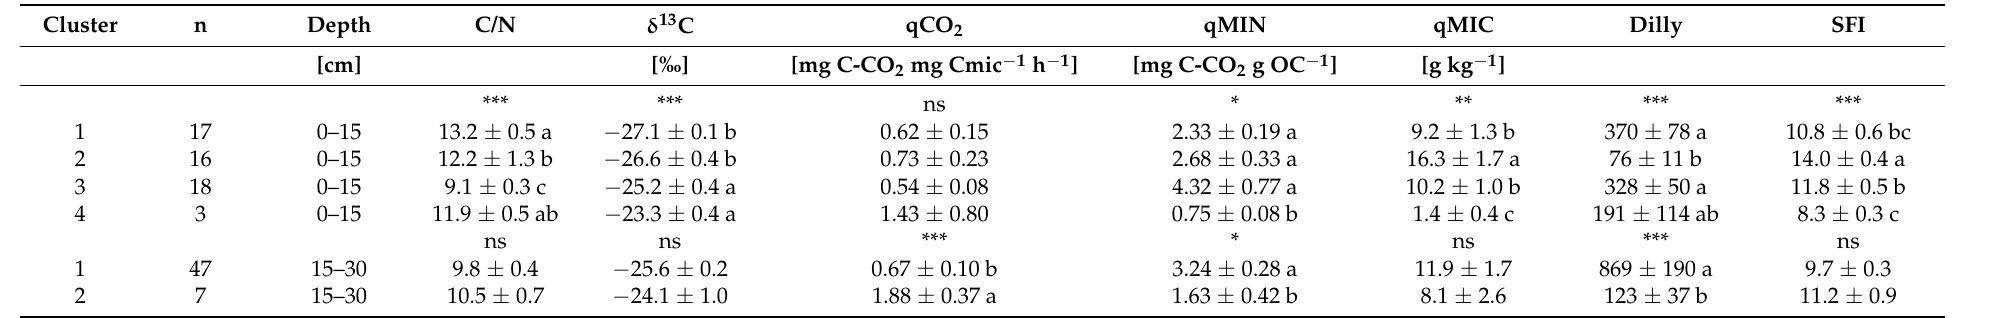
Table 2. Means ± standard errors of several indicators of each cluster at 0–15 and 15–30 cm depth, with the Kruskal–Wallis significance presented as letters and symbols. C/N—OC and TN ratio; δ 13 C—carbon isotopic ratio; qCO 2 —metabolic quotient; qMIN—mineralization quotient; qMIC—microbial quotient; Dilly—Dilly’s index; SFI—soil biofertility index. Different letters for each soil layer and within each column indicate significant differences. * p -value < 0.05; ** p -value < 0.01; *** p -value < 0.001; ns—not